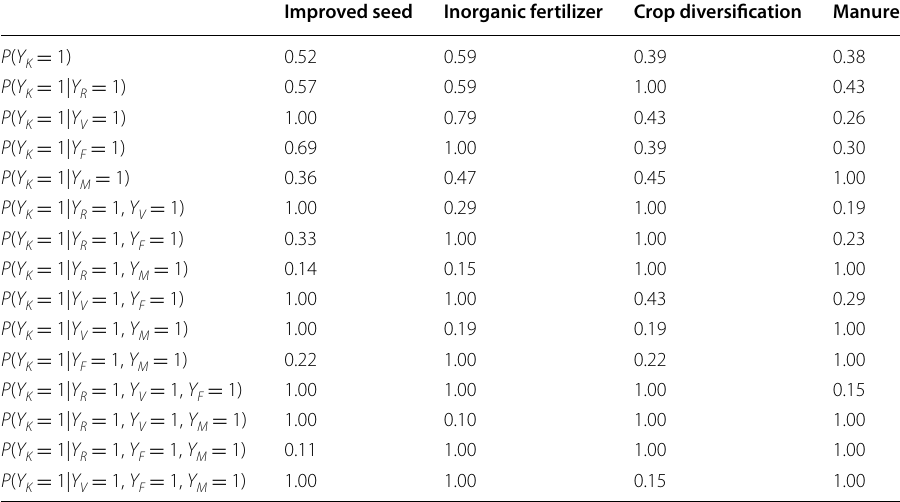
Y K is a binary variable representing the adoption status with respect to practice K ( K ( F ), crop diversification ( R ), manure ( M